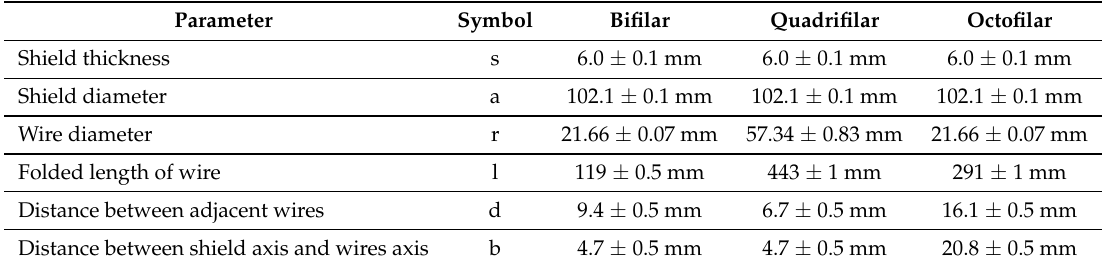
Table 1. Dimensions of bifilar, quadrifilar, and octofilar